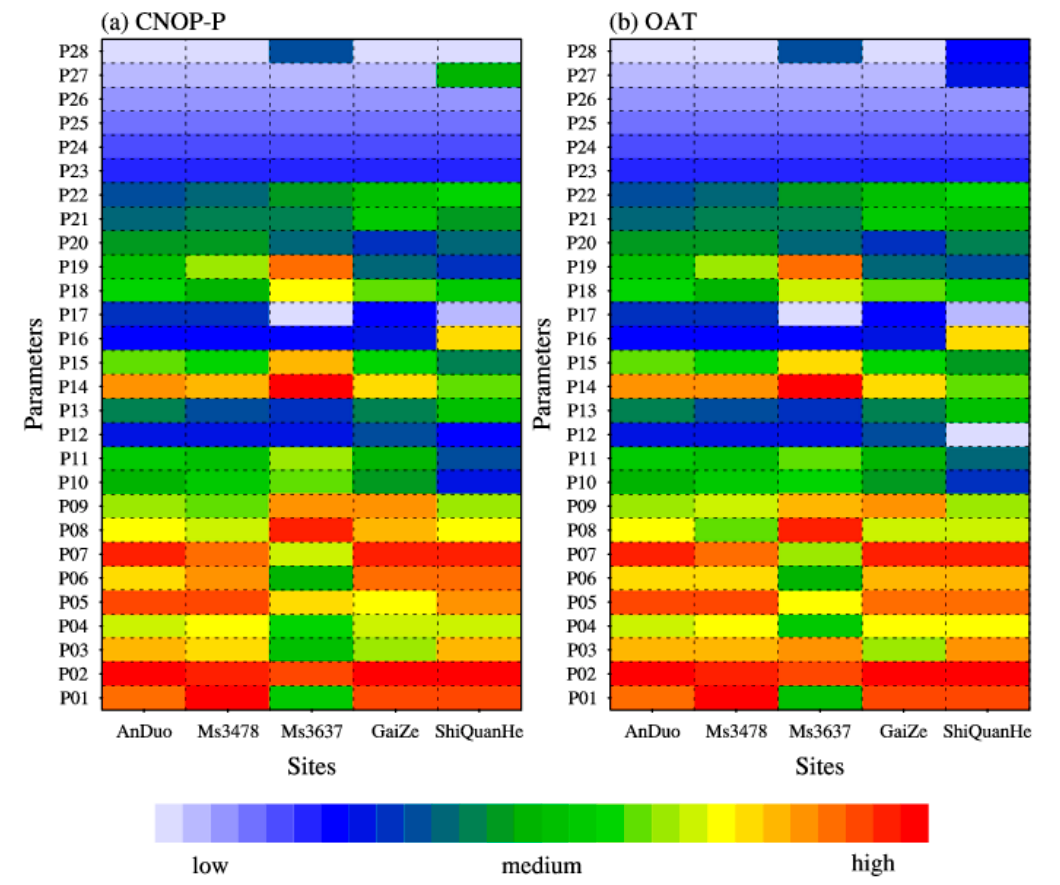
Figure 8. The ranks of the sensitivities of all 28 parameters based on single parameter sensitivity analyses using the CNOP-P approach ( a ) and the one-at-a-time (OAT) method ( b ) for SH.